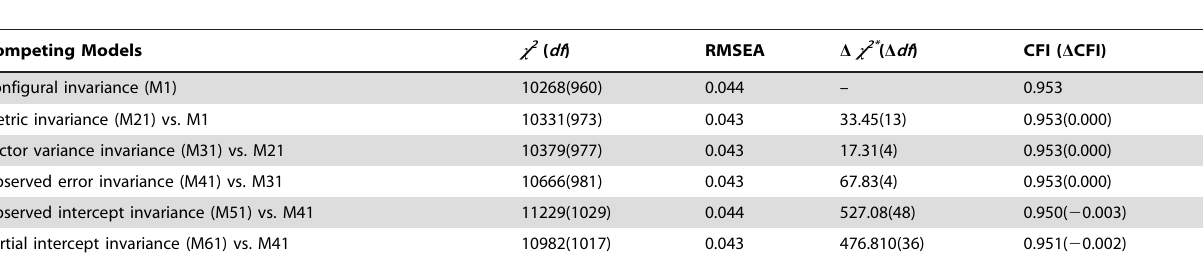
Table 5. Longitudinal measurement invariance tests of demand-control-support factor model across 2008 & 2010.